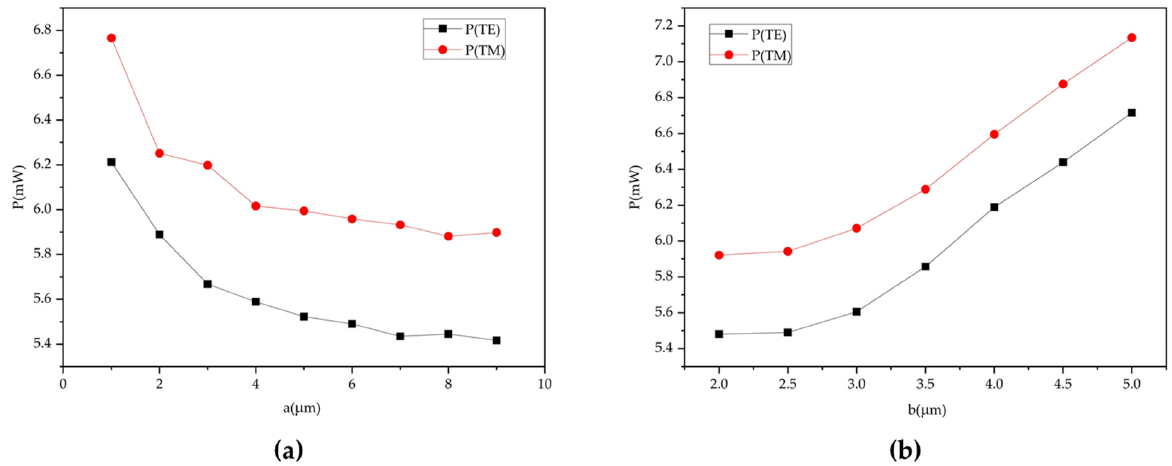
Figure 7. ( a ) Relationship between the switching power and the width of the air trench. ( b ) Relationship between the switching power and the distance from the air trench boundary to the core.